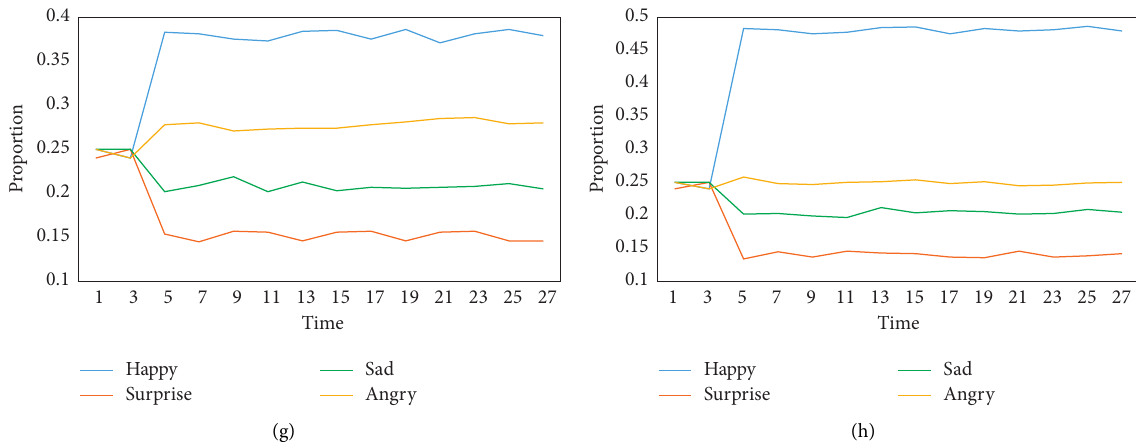
Figure 7: The changing of sentiment in four datasets. (a) Military parade in National Day topic #1. (b) Military parade in National Day topic #2. (c) The assault on a doctor topic #1. (d) The assault on a doctor topic #2. (e) Hong Kong’s event topic #1. (f) Hong Kong’s event topic #2. (g) Garbage sorting in Shanghai topic #1. (h) Garbage sorting in Shanghai topic